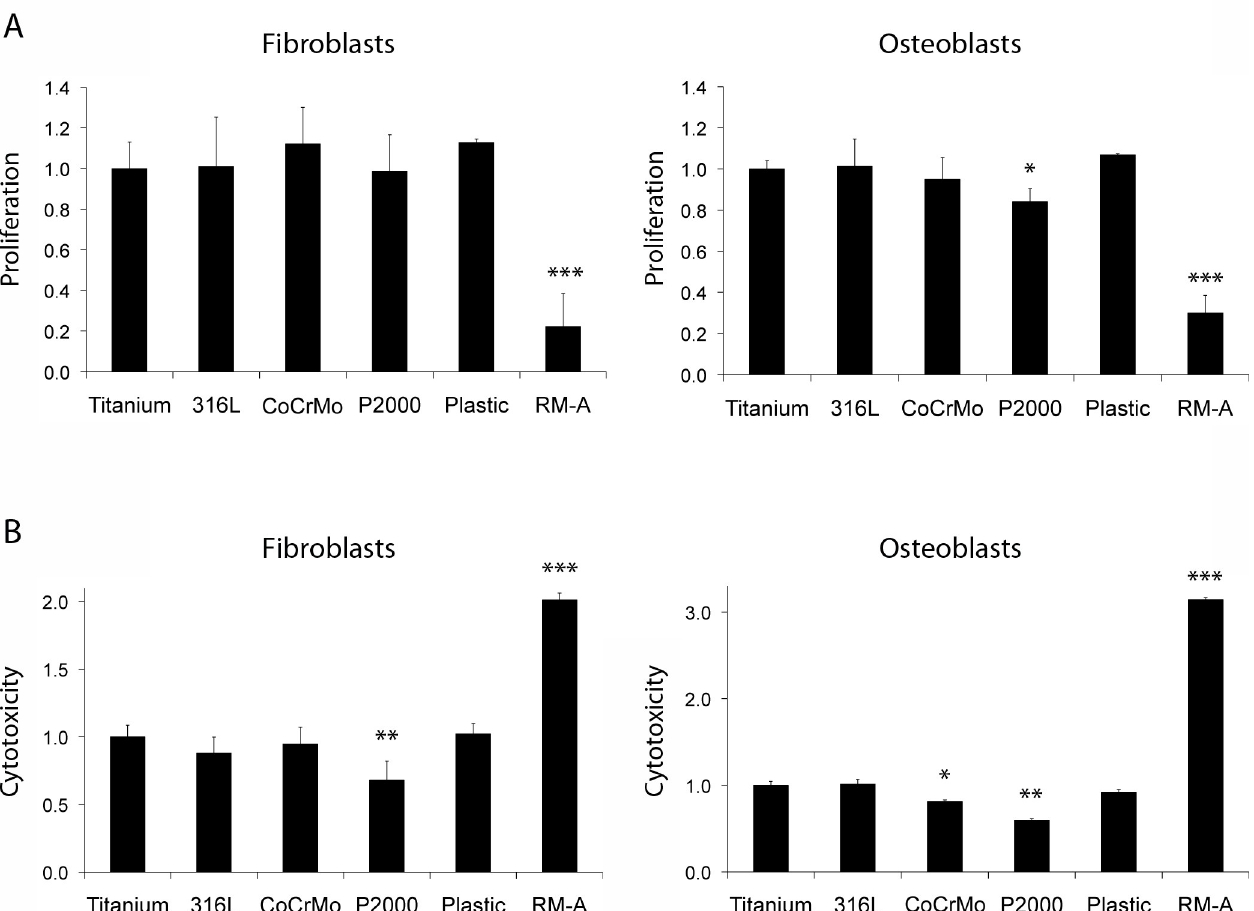
Fig 2. XTT proliferation (A) and LDH cytotoxicity (B) assays. Fibroblasts and osteoblasts grown for 24 h on different samples were stained. Cells were grown on plastic cell culture plates as positive controls and on RM-A sheets as negative controls. Data are presented as mean ± S.E.M. Student’s